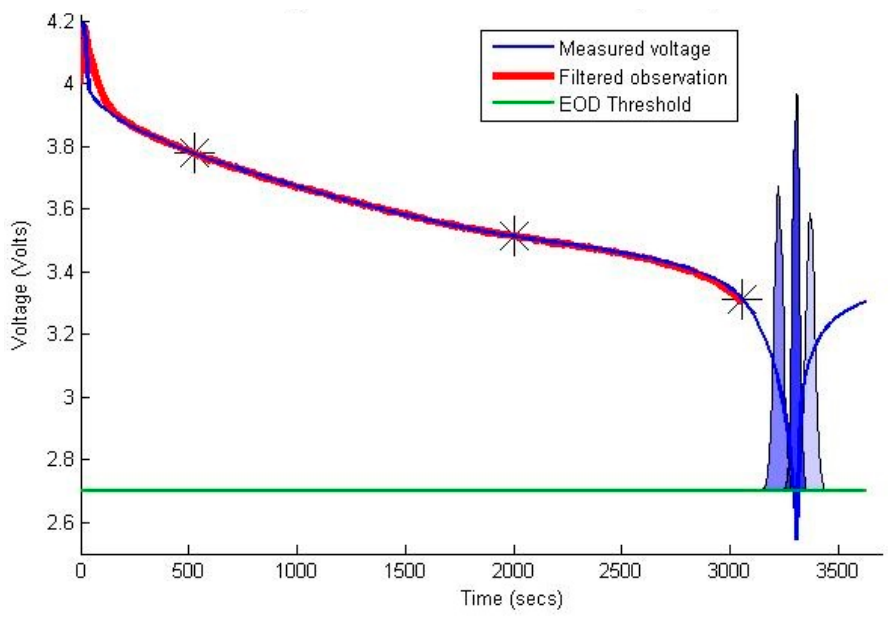
Figure 13. EOD prediction in discharge cycle 5 of cell B0005.